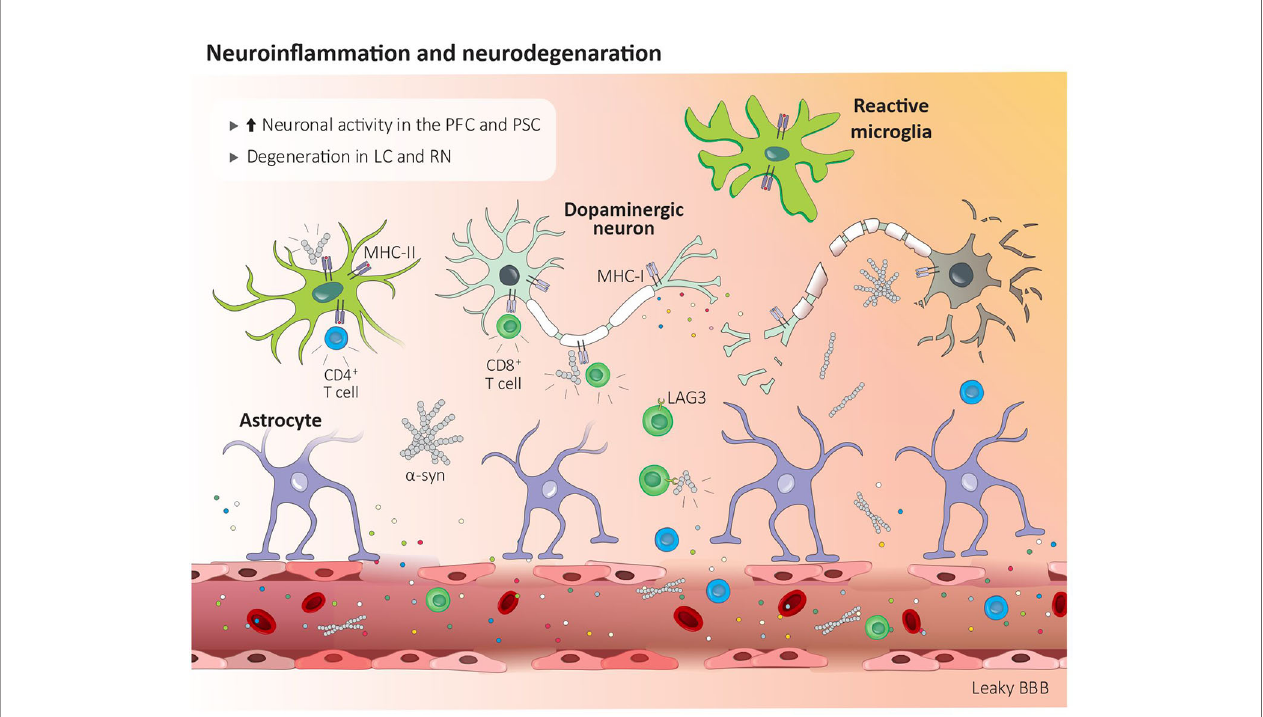
FIGURE 2 | Central in fl ammation in Parkinson ’ s disease. Peripheral in fl ammation increases the blood brain barrier permeability which facilitates the in fi ltration of CD4 + and CD8 + T cells. Lag3 + CD8 T cells help disseminate a -syn centrally, while brain circulating a -syn-reactive CD4 + and CD8 + T cells recognize MHC-II bound peptides on microglia and MHC-I on dopaminergic neurons. Modi fi ed a -synuclein acts as a damage-associated molecular pattern, and via its action on receptors found on microglia and macrophages, induces cytokines release and neurodegeneration. BBB, blood brain barrier; LAG3, lymphocyte activation gene-3; LC, locus coeruleus; MHC-I, major histocompatibility complex I; MHC-II, major histocompatibility complex II; PFC, prefrontal cortex; PSC, primary somatosensory cortex; RN, raphe nuclei; a -syn, a